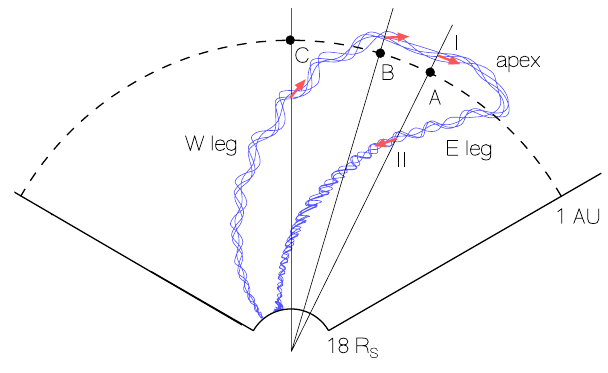
Fig. 1. Simulated flux rope lying in the ecliptic plane, after it reached 1AU. Thin helical lines in blue are magnetic field lines of the flux rope. Parts of the flux rope are labeled as apex, W (west) leg, and E (east) leg. The thick solid lines are boundaries of a computational domain ( R S means the solar radius), the dashed arc shows the distance of 1AU. A more detailed description is in the